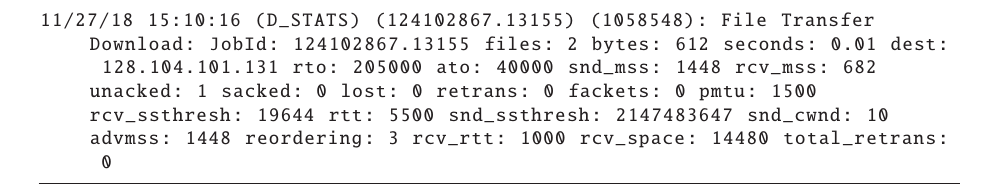
Figure 3. Example HTCondor TCP Log Message